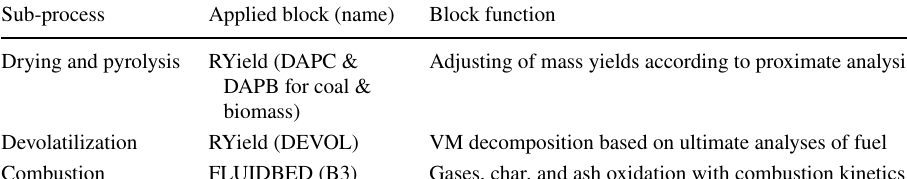
Table 3 Summary of main